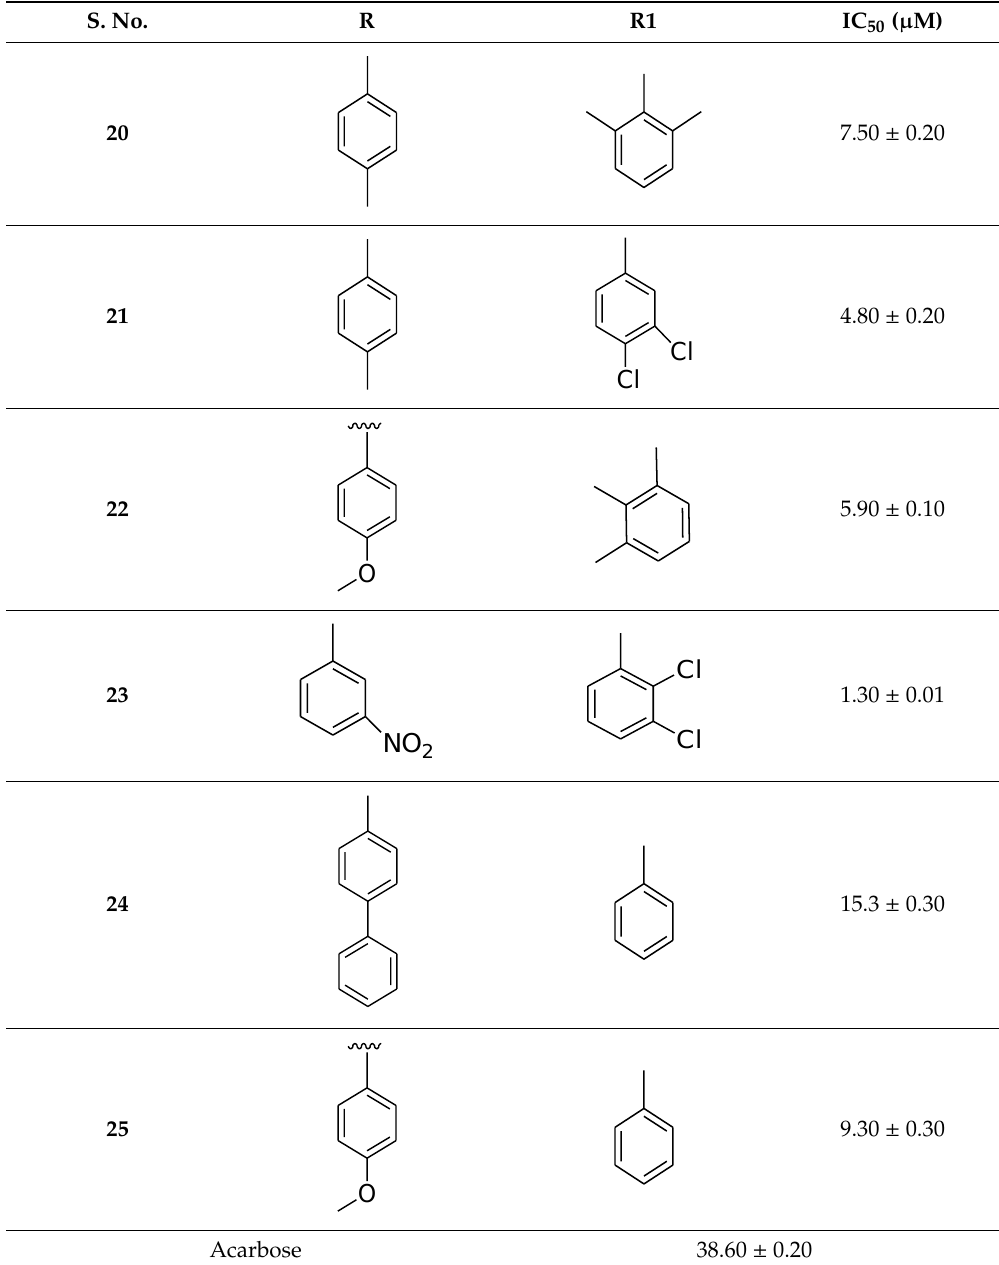
Table 1. Structure of triazinoindole-based thiosemicarbazide analogs and their α-glucosidase activity. S.